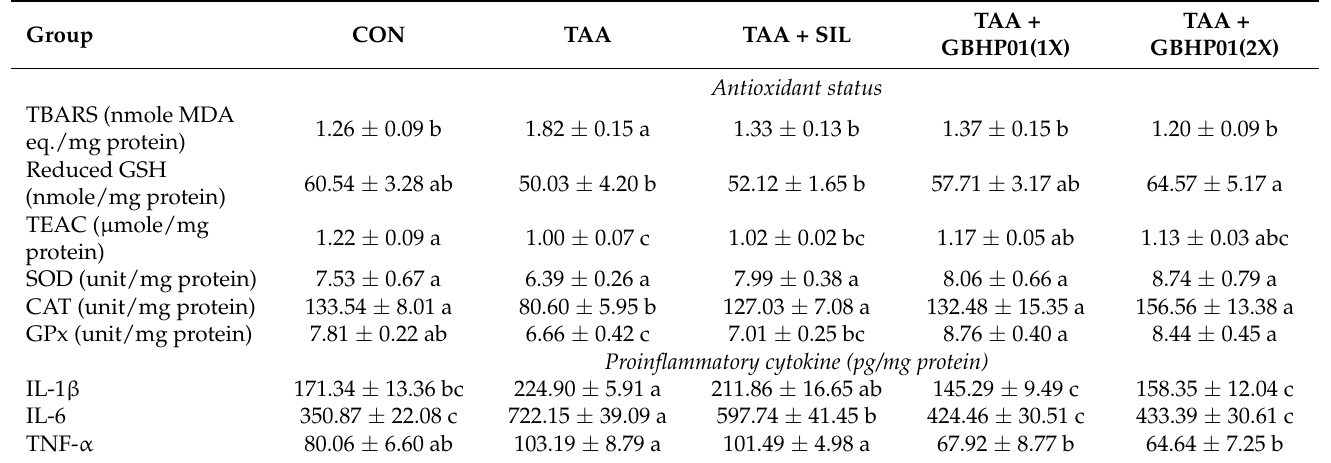
Table 2. Effects of chicken liver hydrolysate-based supplement (GBHP01 TM ) on antioxidative status and proinflammatory cytokines in livers of experimental